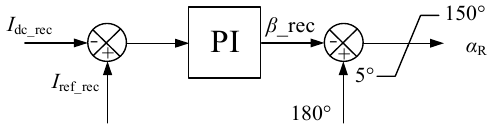
Figure 5. Rectifier LCC control strategy.